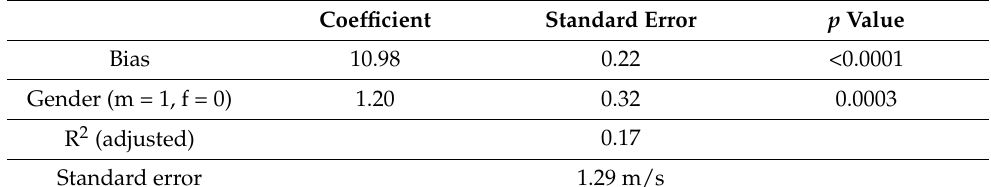
Table 3. Linear regression model of AT stiffness in professional athletes only for gender.